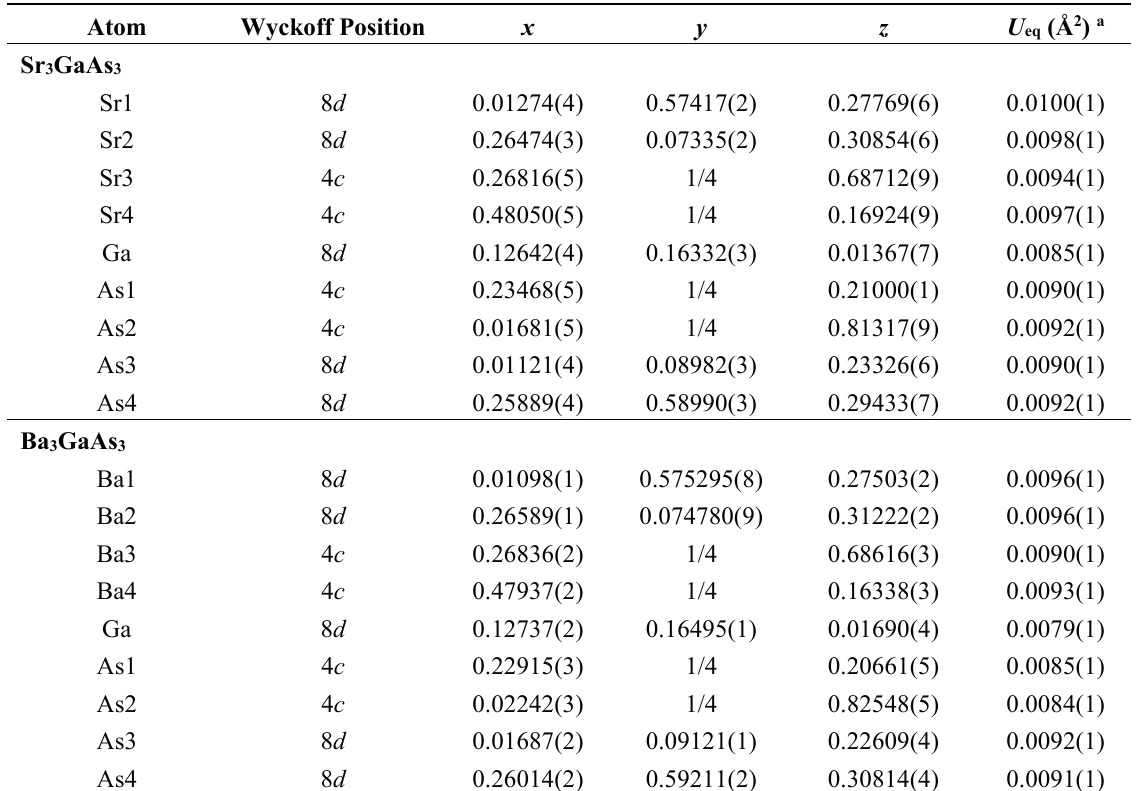
Table 4. Positional and equivalent isotropic displacement parameters for AE 3 GaAs 3 ( AE = Sr, Ba).